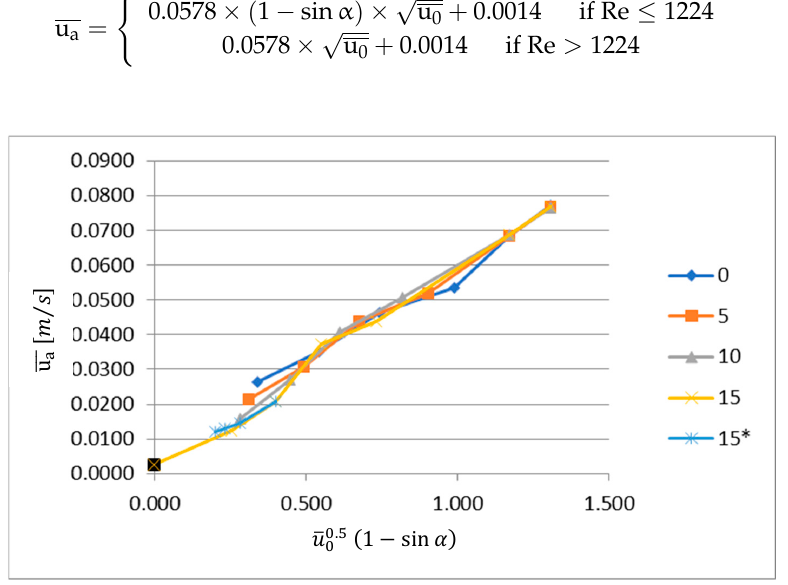
Figure 9. Relation between the average velocity at the opening and u (cid:2868) (cid:3364)(cid:3364)(cid:3364) (cid:2868).(cid:2873) (cid:4666)1 (cid:3398) sinα(cid:4667) for different jet angles (15* values correspond to tests with variation in jet thickness).